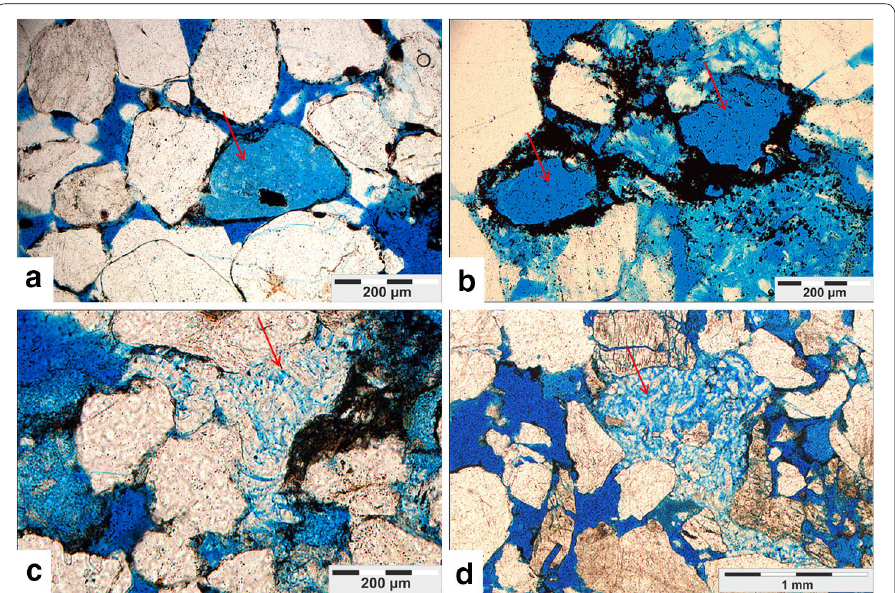
Fig. 6 Thin section photographs of sandstone samples (blue stained epoxy), showing a altered alkali feldspar showing dissolution effects (red arrow), b ferrogeneous ghost structure remains of completely dissolved alkali feldspar (red arrows), c , d authigenic, worm-like kaolinite booklets (red arrows), resulting from alkali feldspar degeneration ( a Buntsandstein sandstone, Hardegsen Formation; b – d Keuper sandstone, Löwenstein Formation/Upper